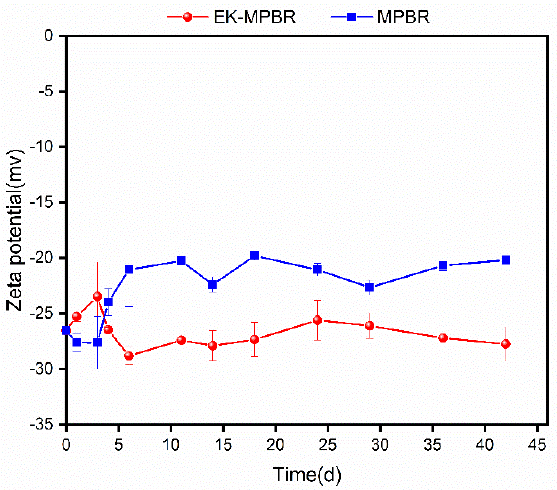
Figure 3. Nutrient removal of MPBR and EK-MPBR: ( a ) comparison of TP removal efficiency, ( b ) TN removal efficiency, and ( c ) COD removal efficiency.